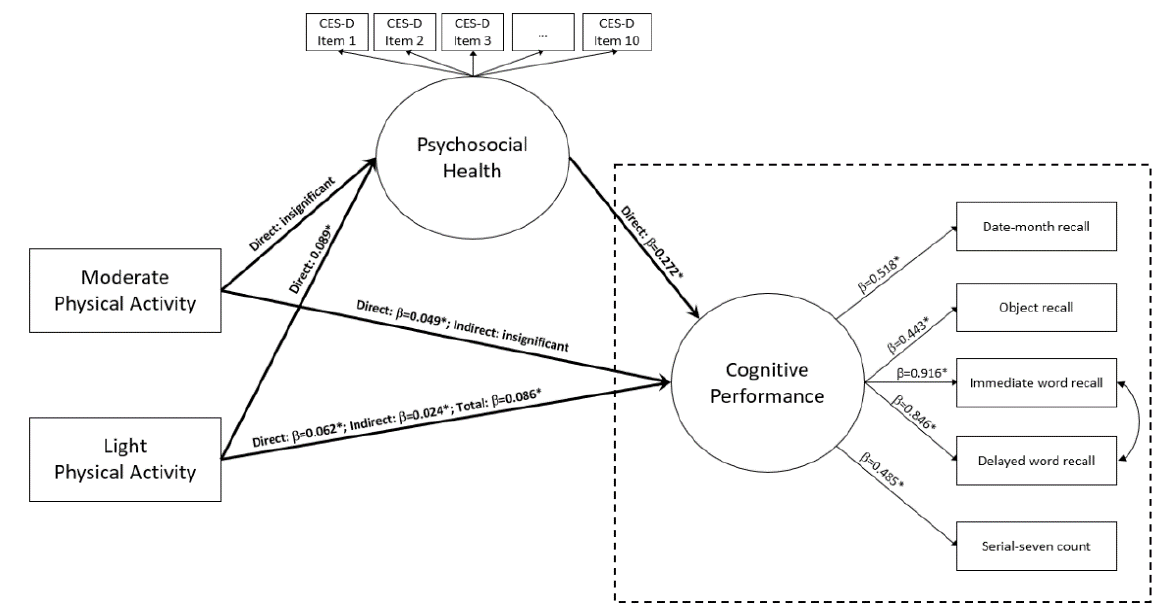
Figure 1. Standardized solution of the structural mediation model. Note: * denotes p < 0.05. Model fit indices: χ 2 135 = 21426.79 ( p < 0.001), CFI = 0.905, TLI = 0.889, RMSEA = 0.06, and SRMR =